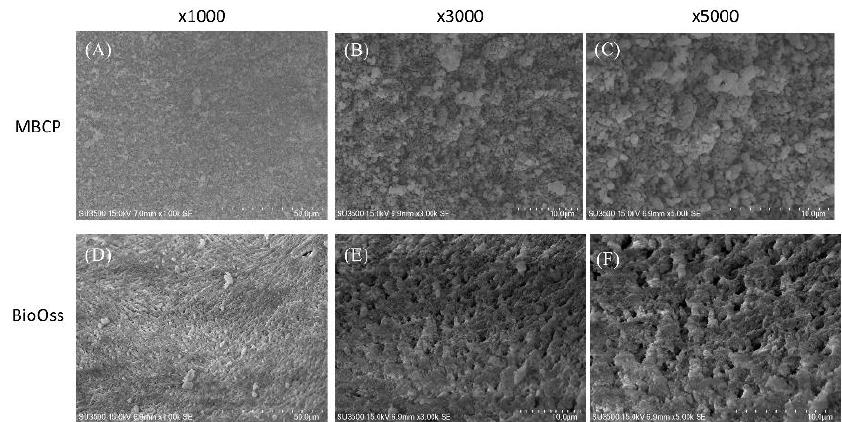
Figure 1. SEM images of MBCP and Bio-Oss at different magnifications ( × 1000, × 3000, and × 5000). ( A – C ) Morphology evaluation of MBCP at increasing magnification. ( D – F ) Morphology evaluation of Bio-Oss at increasing magnification.